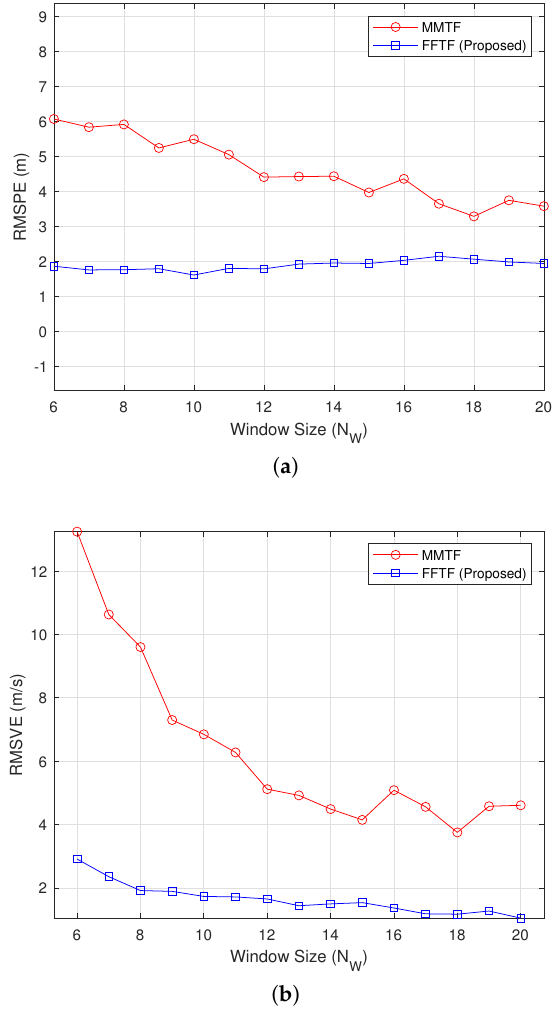
Figure 3. Simulation results under the mid-range mode ( D r = 50 m): ( a ) RMSPE; ( b )